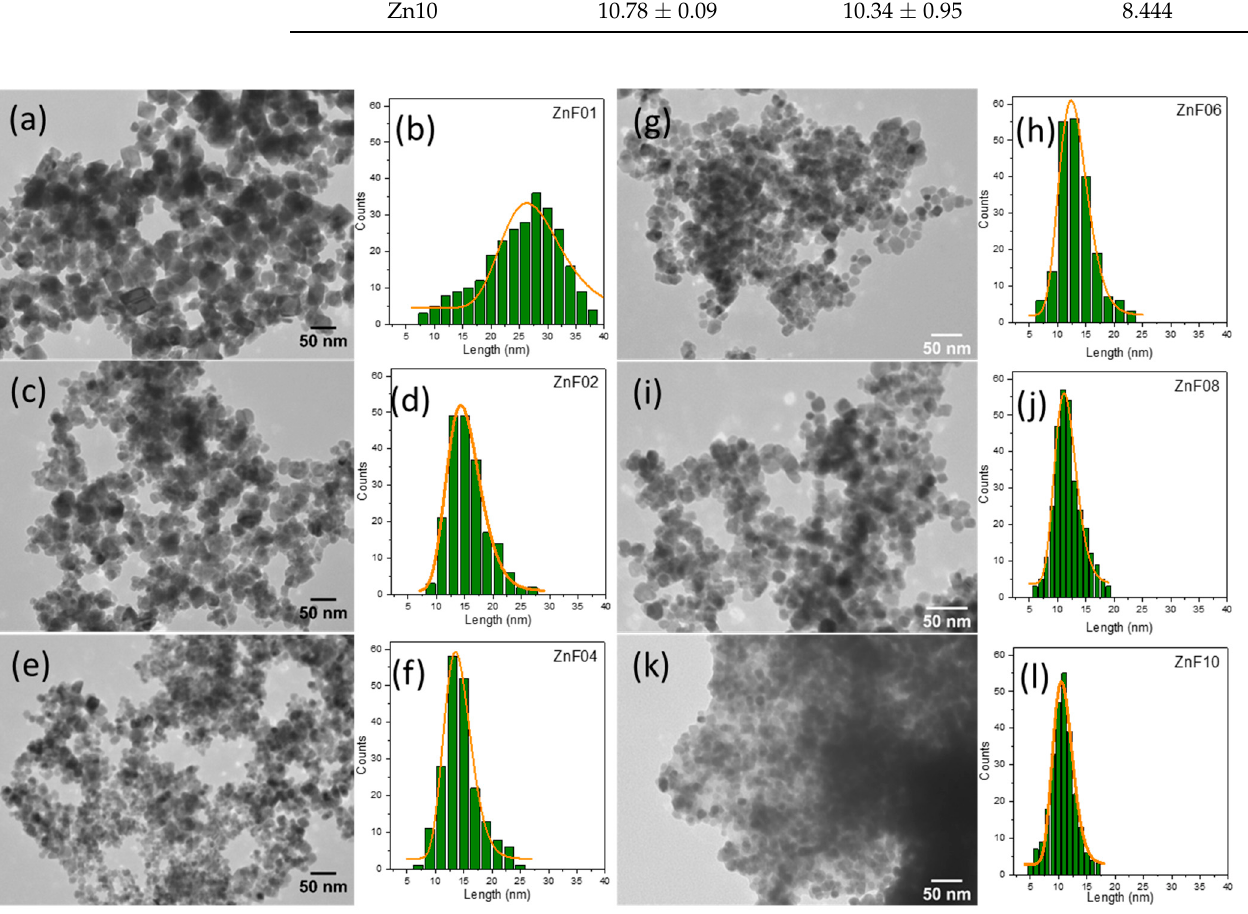
Figure 1. TEM images of ZnF particles and their size distribution histograms fitted to a log-normal distribution (orange lines): ( a ) and ( b ) ZnF01, ( c ) and ( d ) ZnF02, ( e ) and ( f ) ZnF04, ( g ) and ( h ) ZnF06, ( i ) and ( j ) ZnF08, ( k ) and ( l ) ZnF10.